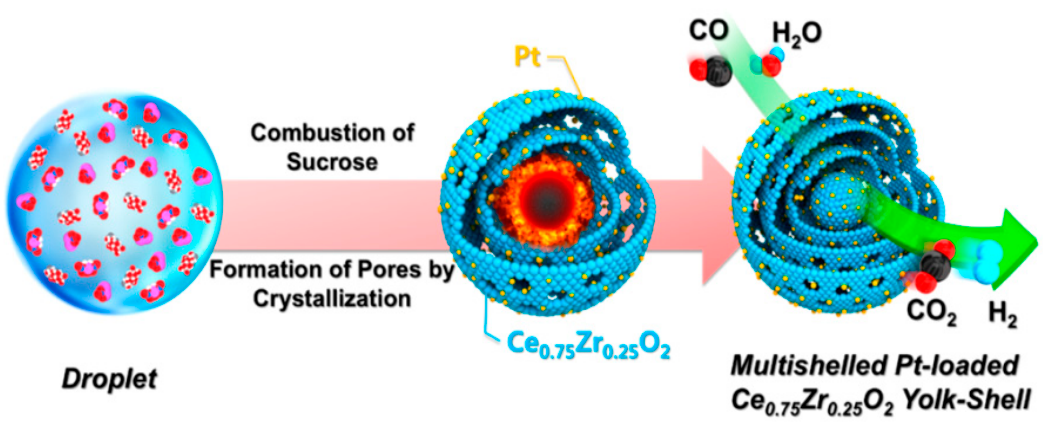
Figure 7. Schematic diagram of the formation mechanism of Pt-doped Ce0 .75 Zr 0.25 O 2 powders with yolk − shell structure, reproduced from [48], with permission from American Chemical Society, 2016.